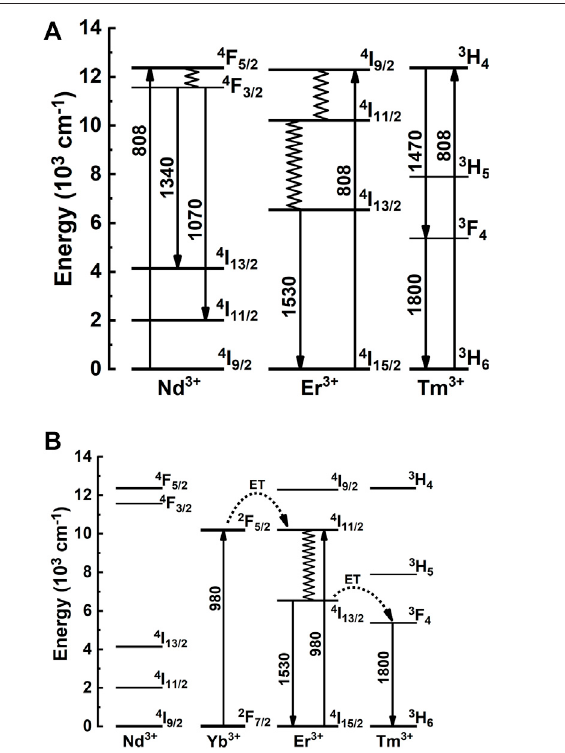
FIGURE8| PartialenergylevelsdiagramoftheNd 3+ ,Er 3+ andTm 3+ ions under excitation at 808 nm (A) , and Yb 3+ , Er 3+ , Tm 3+ ions under excitation at 980 nm (B) and possible excitation/emission